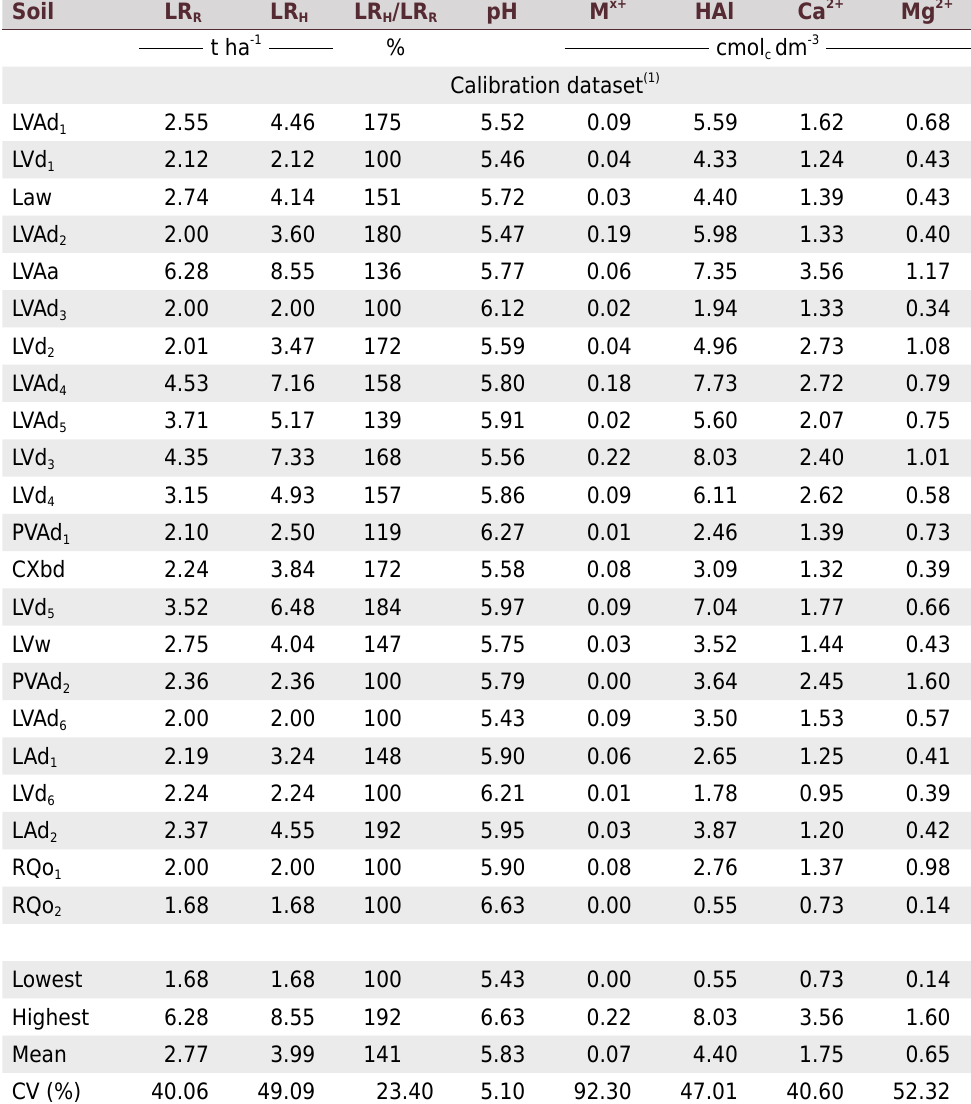
Table 5. Recommended (LR R ) and highest (LR H ) lime requirement and selected soil characteristics associated with LR R for the soils used to develop the new predictive models Soil